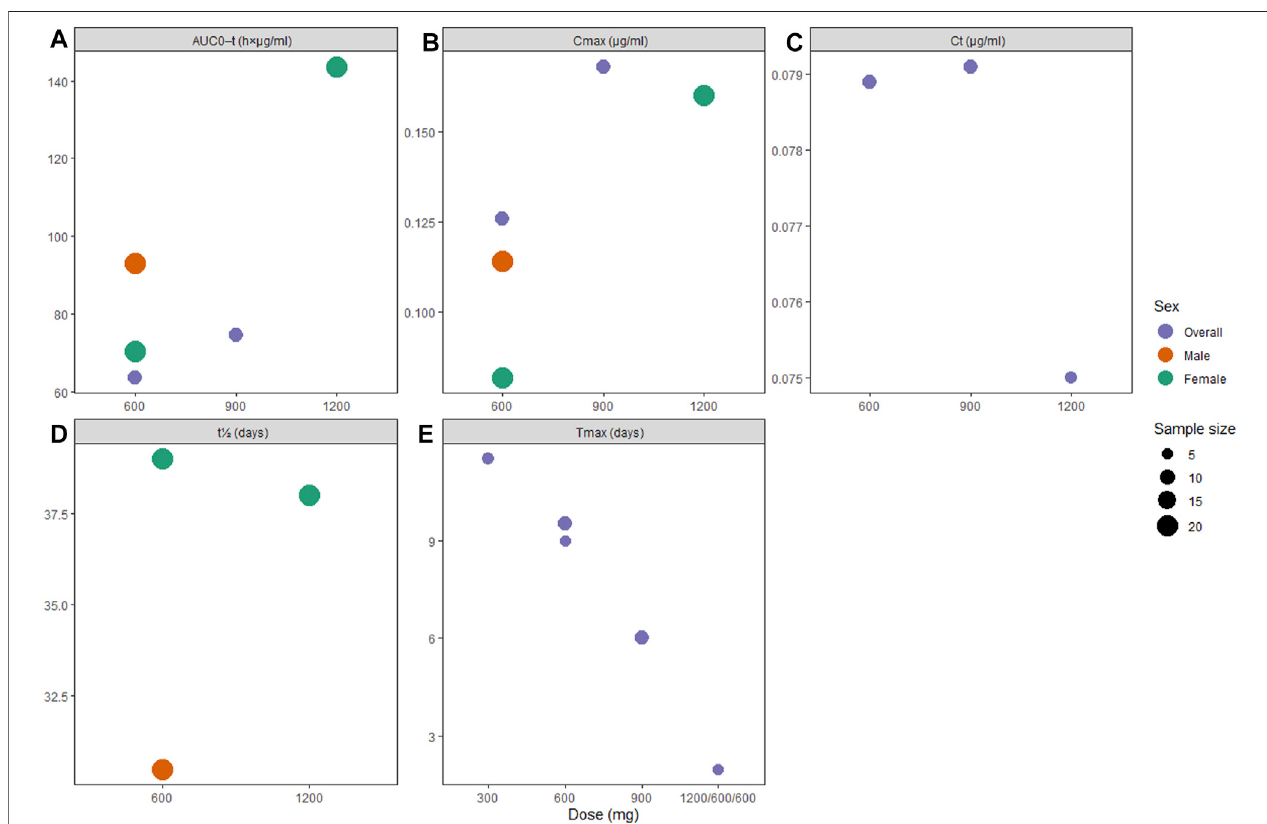
FIGURE4| Pharmacokineticpro fi lesoflong-actingrilpivirinefollowingthe fi nalinjection: (A) areaunderthecurve(AUC)fromadministrationtimeto τ time, (B) peak concentration (C max ), (C) concentration through τ time (C τ ), (D) apparent half-life (t 1/2 ), and (E) time to peak concentration (T max ).